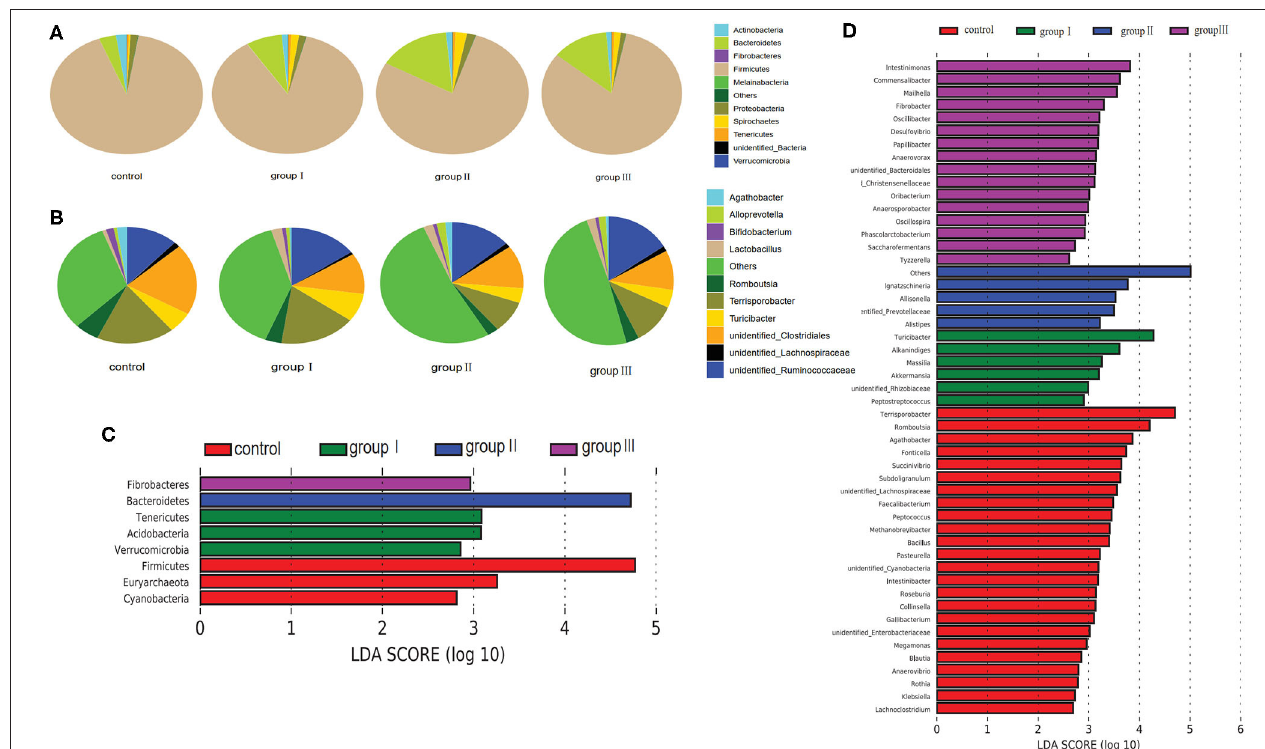
FIGURE 4 | Composition analysis of bacteria in the cecum from four dietary groups. Microbial composition at the phylum (A) and genus (B) level. LEfSe identified significantly different bacteria according to relative abundance among the four dietary groups at the phylum (C) and genus level (D) ( p < 0.05, LDA Score > ± 2.0 at the phylum level, and LDA Score > ± 2.5 at the genus level).